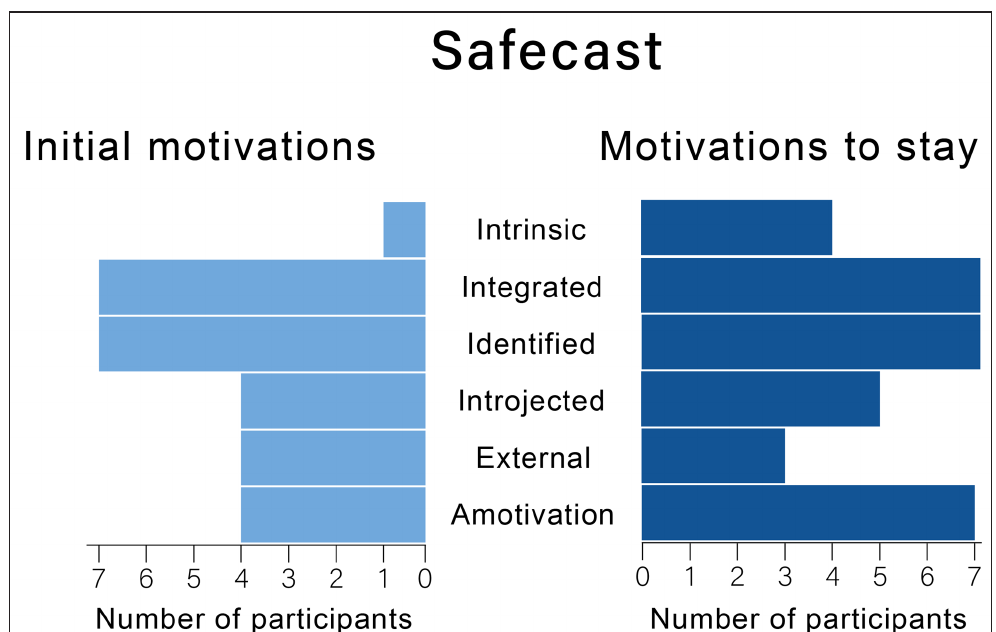
Figure 5: Motivations underlying participation among Safecast